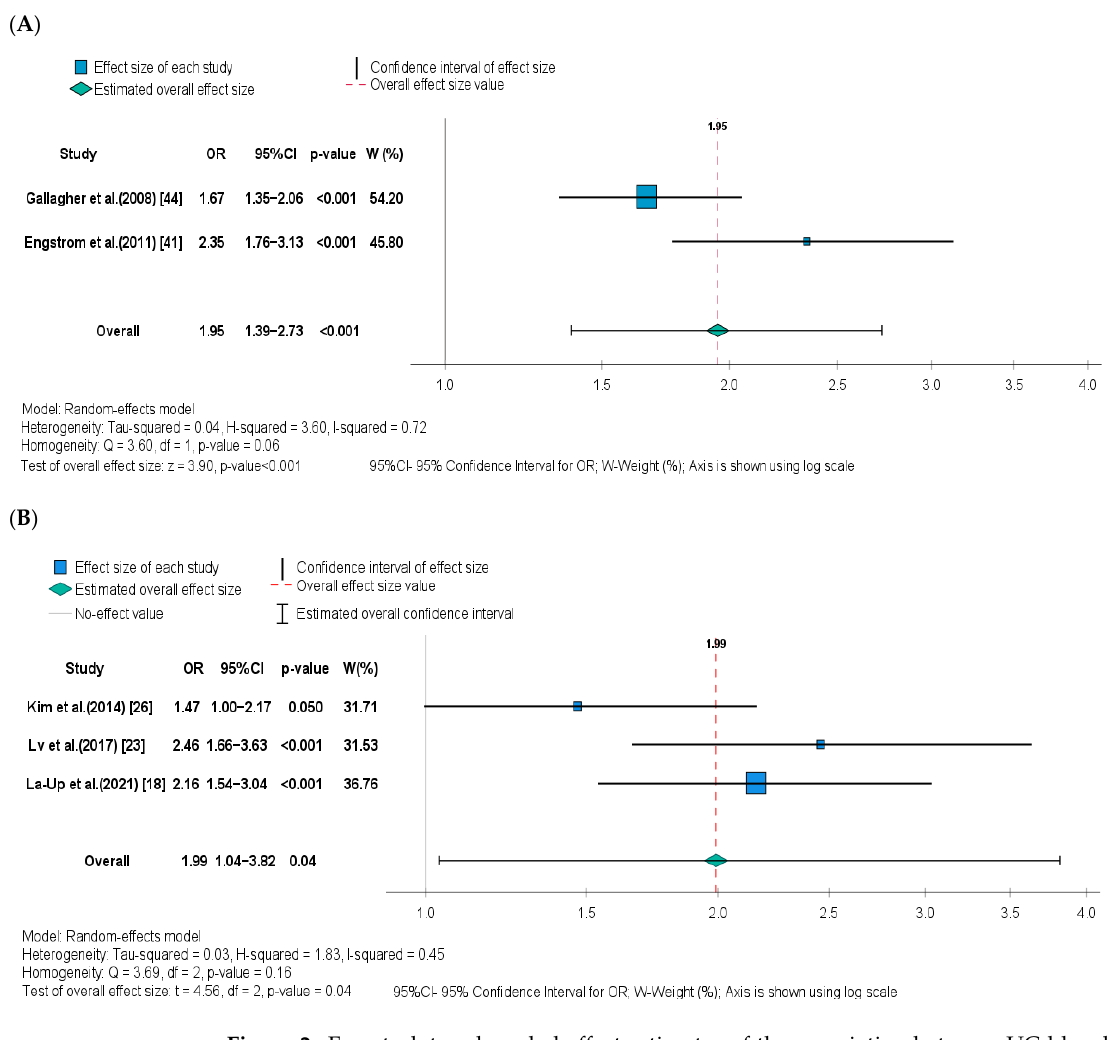
Figure 2. Forest plot and pooled effect estimates of the association between UCd levels and risk of osteoporosis in the ( A ) low-level Cd exposure group [41,44], and ( B ) high-level Cd exposure group [18,23,26].